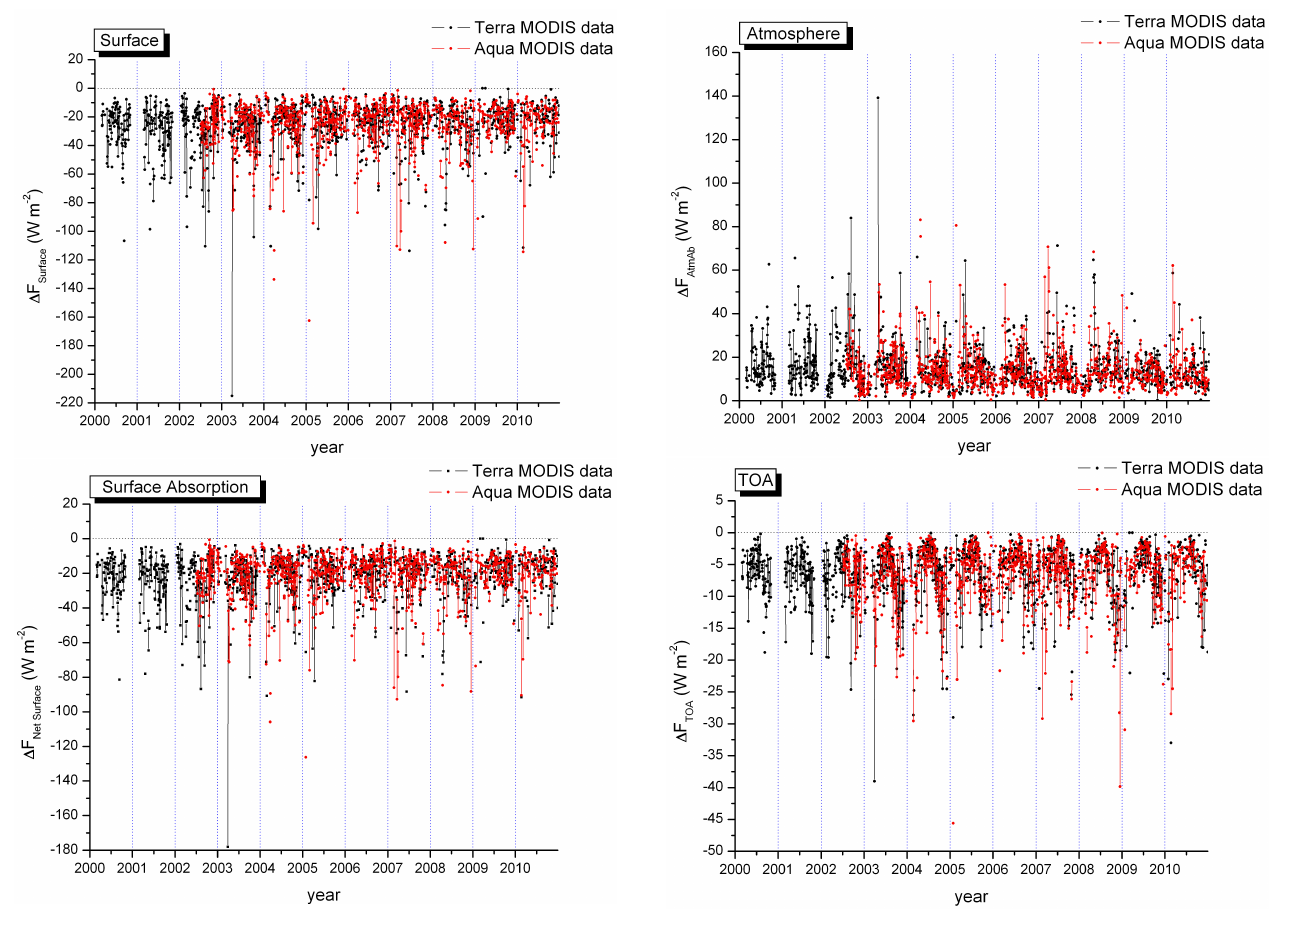
Fig. 7. Time series of the instantaneous aerosol effect at the sur- face (incident (a) and absorbed (b) radiation), as computed from the model, based on MODIS Level 2 Terra and Aqua data, for the period 2000–2010, at the HCMR station, Crete.